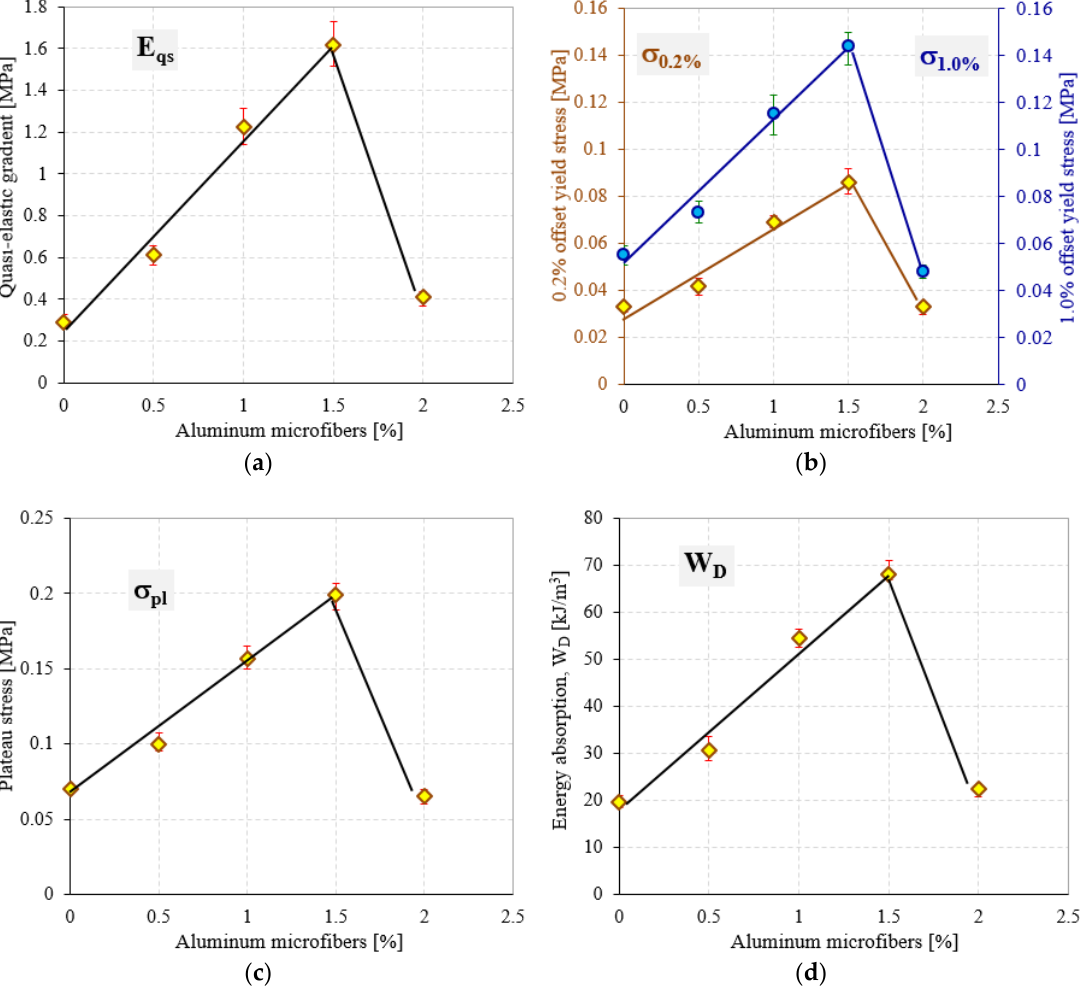
Figure 5. Mechanical properties of investigated semi-rigid PU foams: ( a ) Quasi-elastic gradient; ( b ) 0.2% and 1.0% offset yield stress; ( c ) plateau stress; ( d ) energy absorption at densification strain.